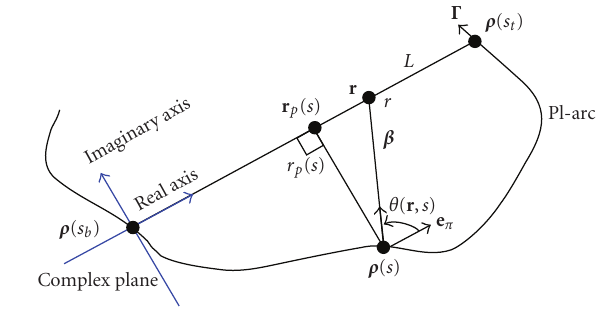
Figure 3: Complex coordinate system for the analytic